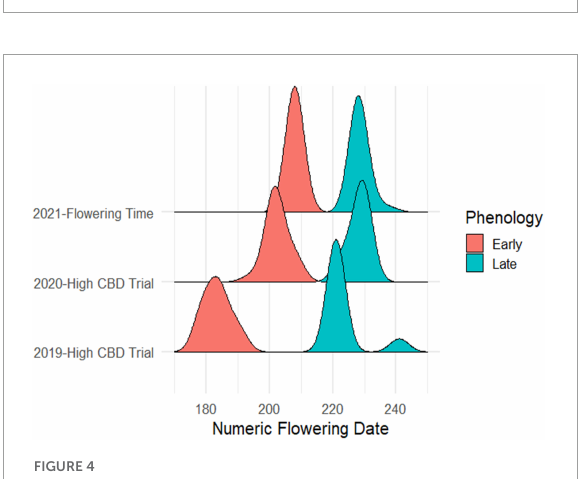
FIGURE4 Density ridge plot of ‘Umpqua’ flowering time in the field over 3 years in Geneva, NY.